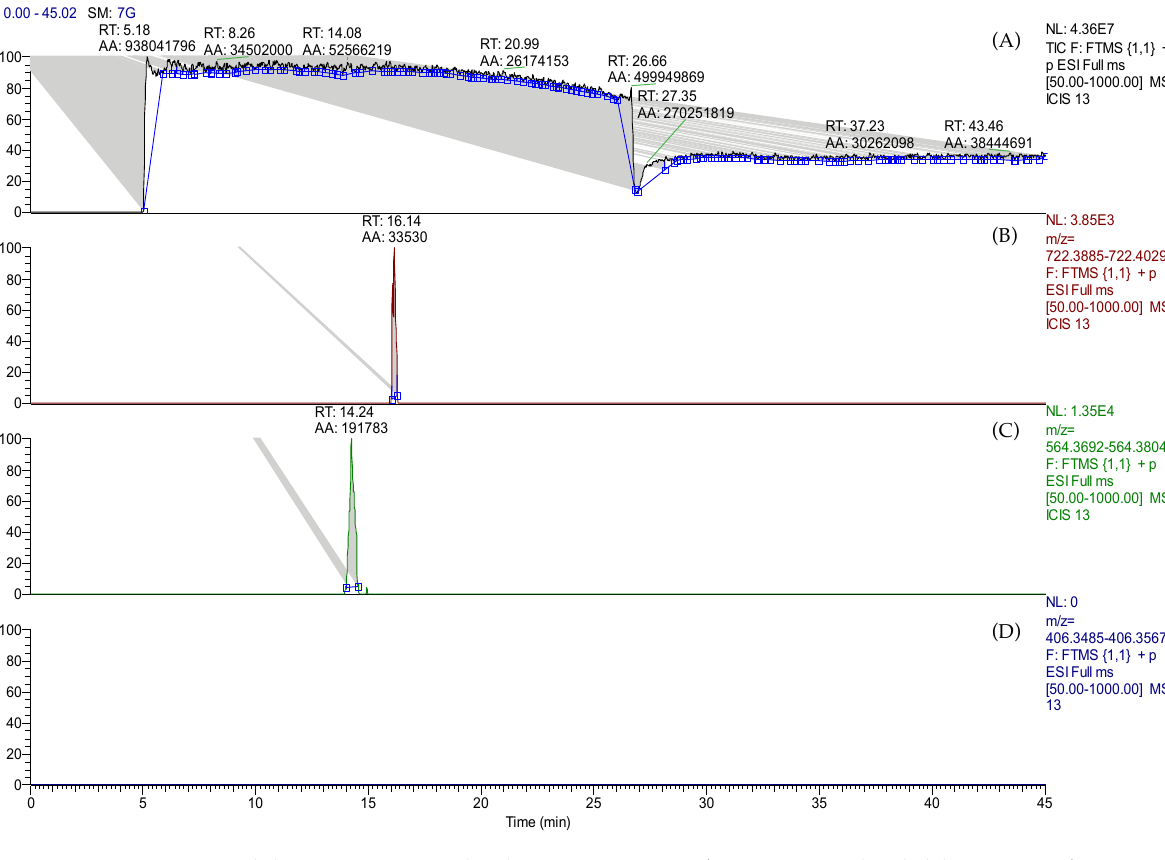
Figure 3. LC-HRMS results. (A) Total Ion Current (TIC) and extracted ion chromatograms (XIC); (B) filtered on the accurate mass of fumonisin B 1 ; (C) partially hydrolyzed form of FB 1 (PHFB 1 ); and (D) hydrolysed fumonisin B 1 (HFB 1 ) in sample ITEM